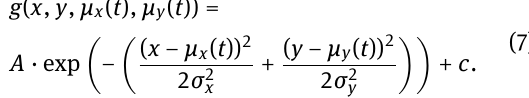
the asymmetrical interaction kernel of the shape field. The asymmetric kernel allows the shape field to move with re- spect to the optical flow